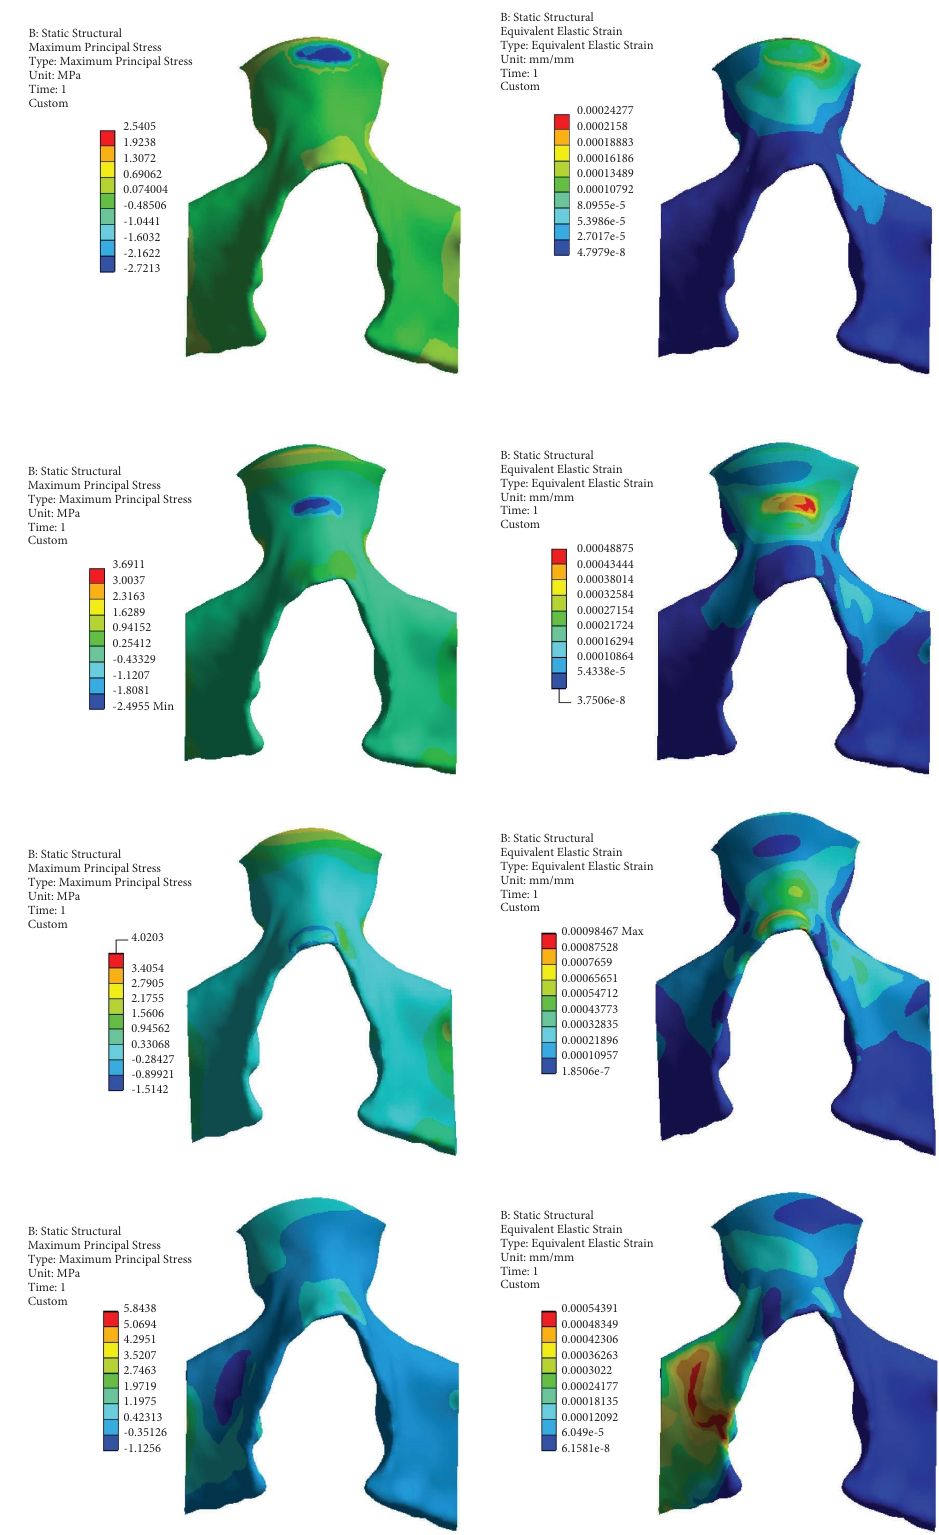
Figure 3: Stress and strain distributions of the upper, middle, and lower nasal bone and nasomaxillary junction under 100N vertical external